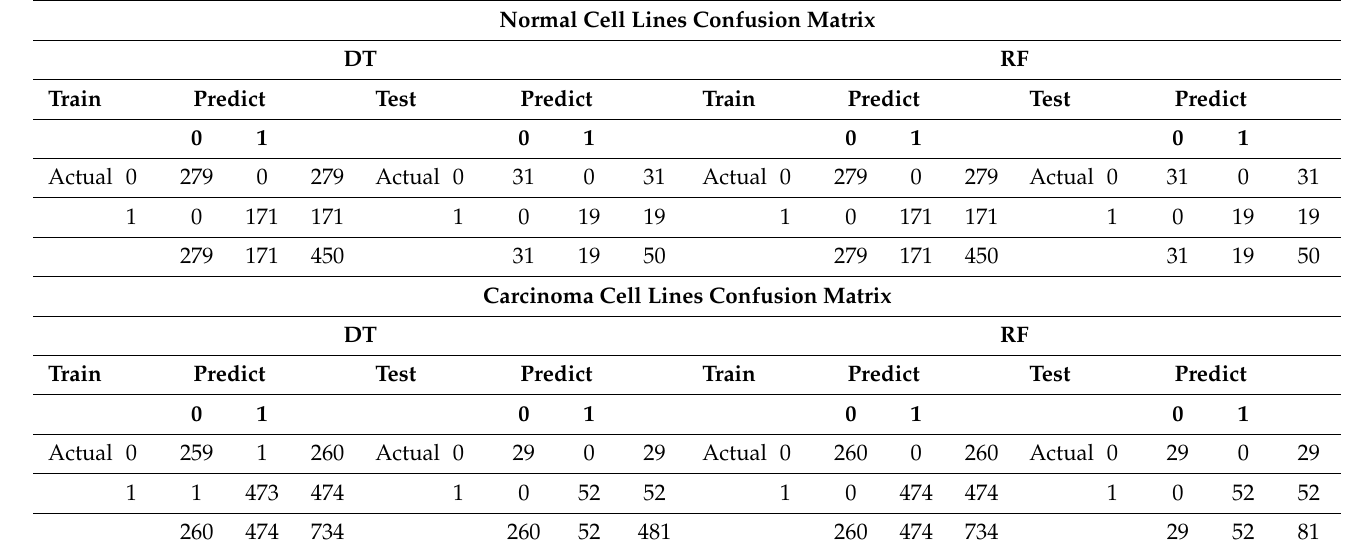
Table 4. Normal and Carcinoma cell lines Confusion